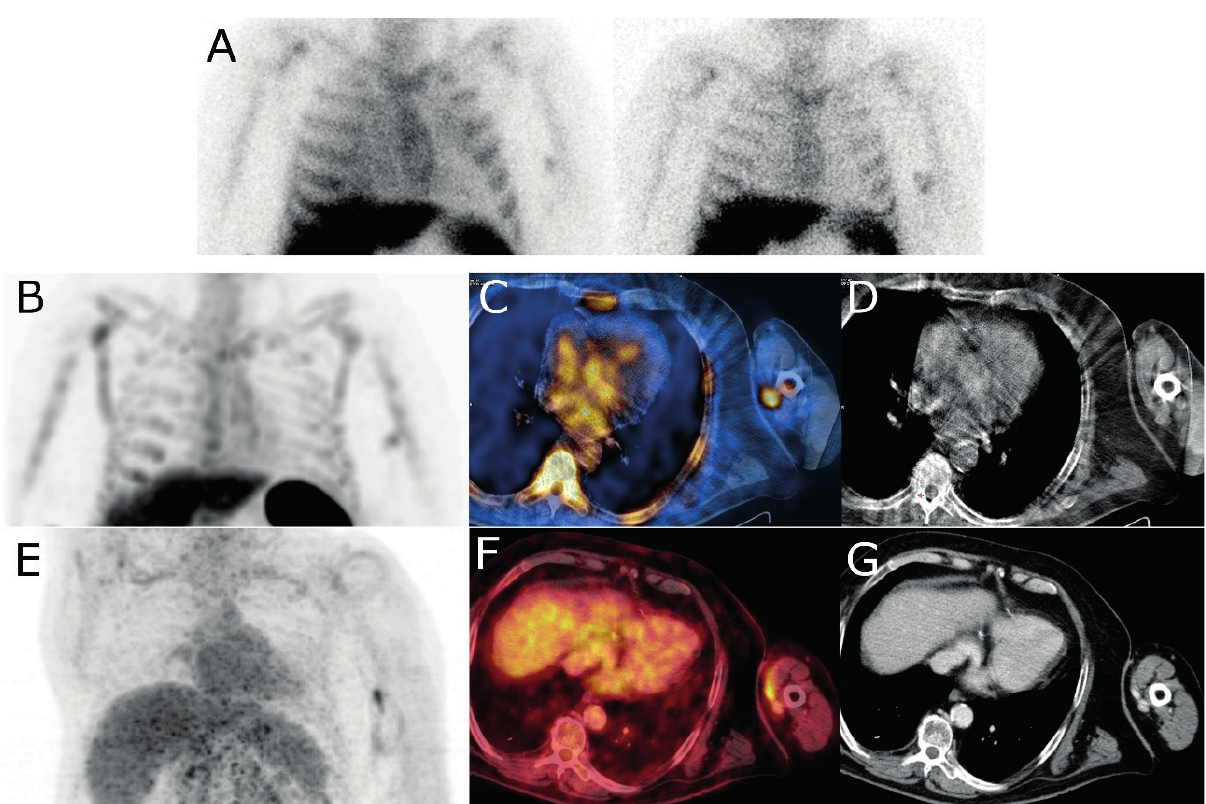
Fig. 1. Imaging of arteriovenous graft infection - subsequent fistula formation despite an antibiotic therapy initiation. Increased focal 99m Tc-HMPAO-WBC uptake – (A) anterior scans acquired 4 and 24 hours post injection, (B) MIP SPET, (C) SPECT/CT, (D) CT. Increased focal 18 F-FDG uptake (E) MIP, (F) PET/CT, (G)